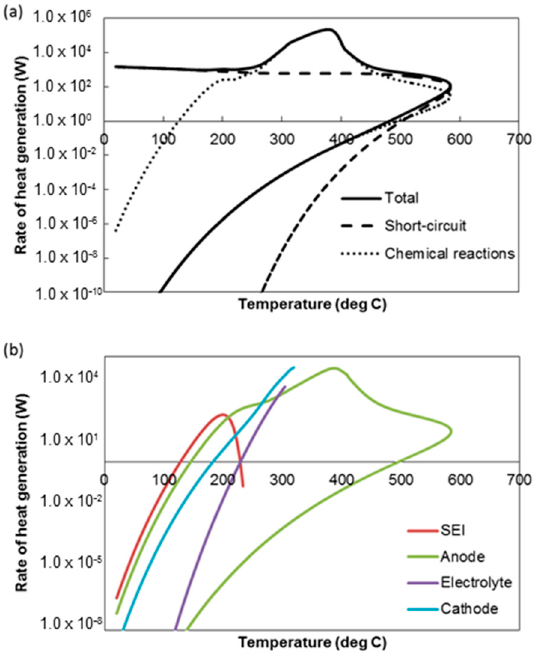
Figure 4. ( a ) Total rate of heat generation, which is a sum of heat released from short-circuit and chemical reactions; ( b ) heat release rate by individual chemical reactions.